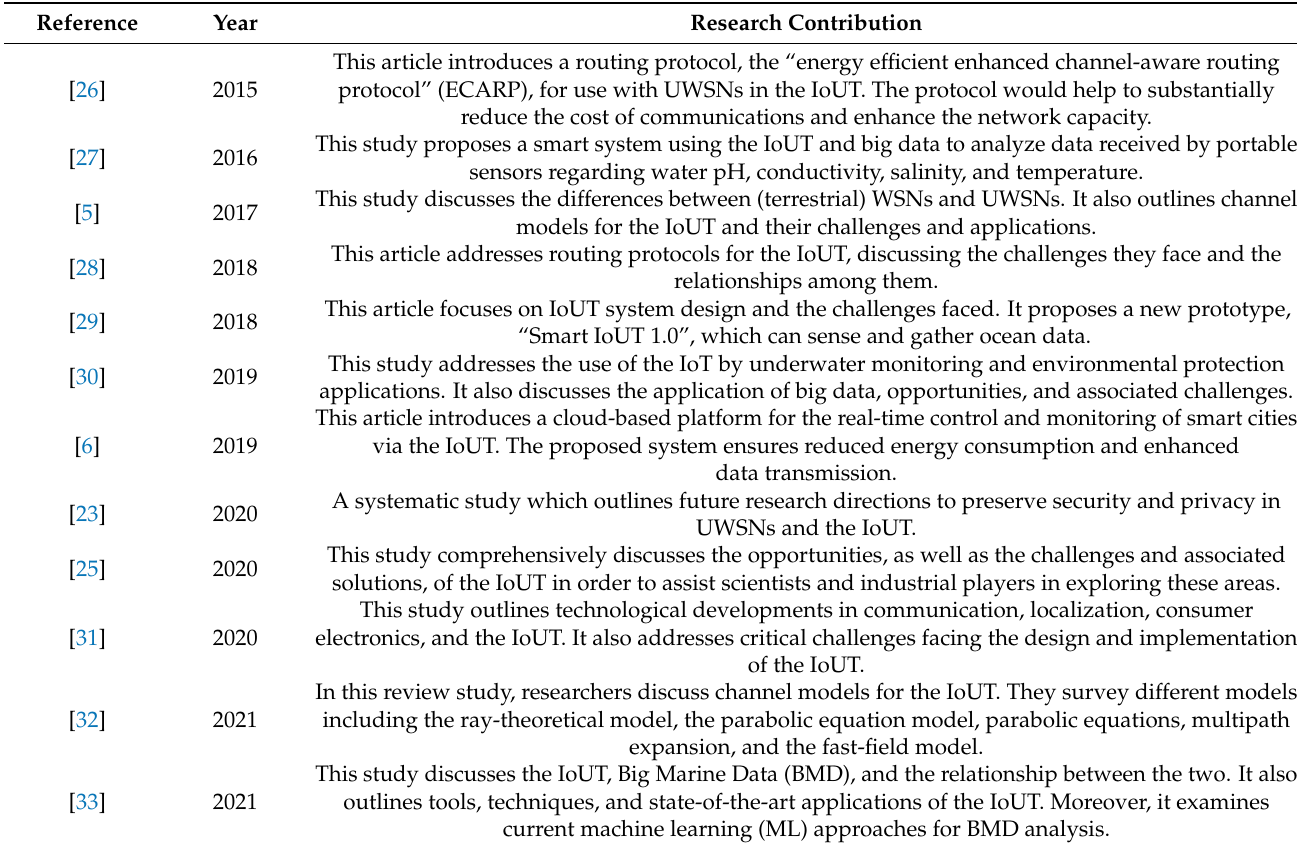
Table 2. Research Contributions on